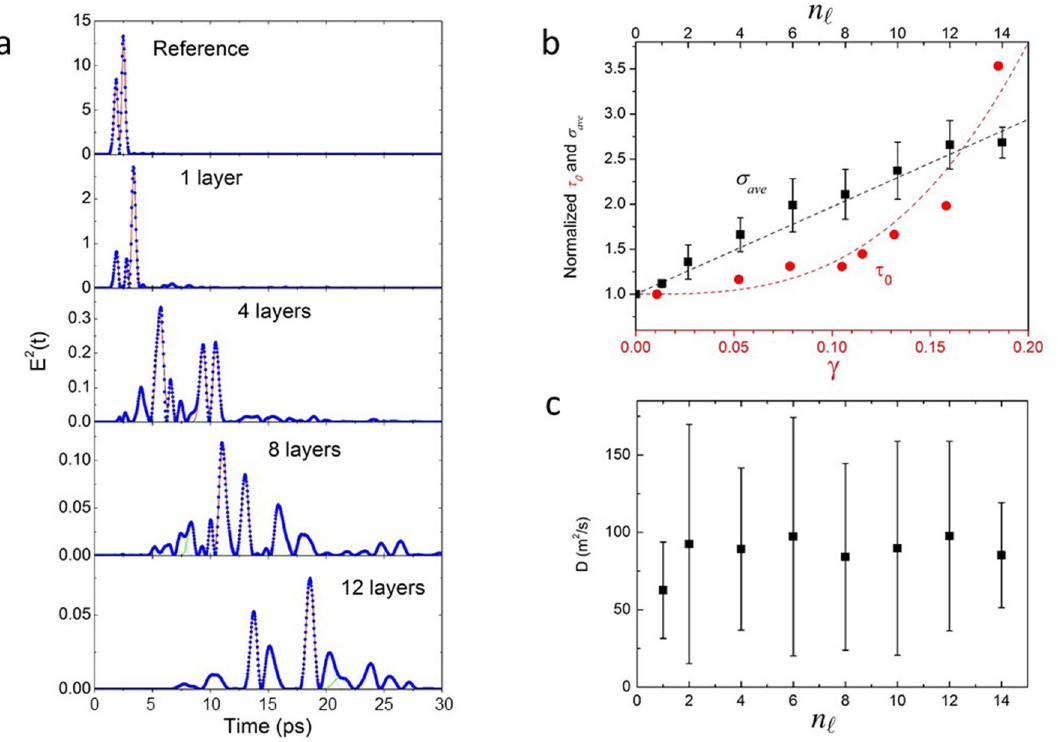
Figure 3. ( a ) The squared module of transmitted THz pulses as a function of n ℓ . ( b ) The normalized THz pulses σ ave as a function of n ℓ (top x axis) and the graph of the normalized τ 0 as a function γ (bottom x axis). The black dashed line is the linear fit of σ ave , the red dashed curve is a third-degree polynomial fit of τ 0 . ( c ) The diffusion constant of the THz pulses within the photonic structures as a function of n ℓ showing a constant